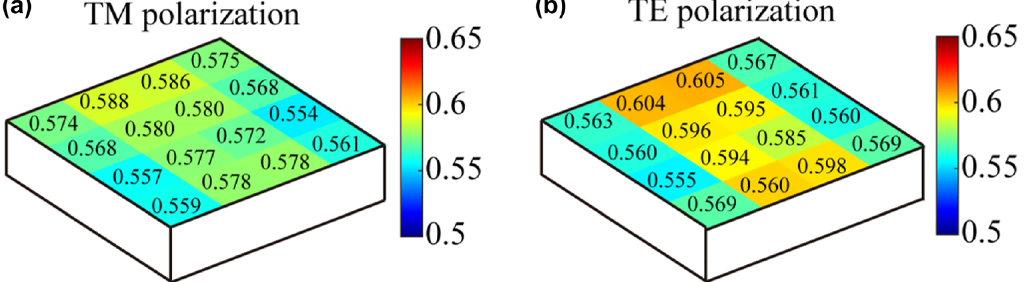
Figure 7: Experimental results of the ( − 1, 0)-order diffracted-light reflection efficiency under (a) transverse-magnetic and (b) transverse-electric polarizations for the two-dimensional grating. Sixteen points were distributed on the full-aperture area in a 4 × 4